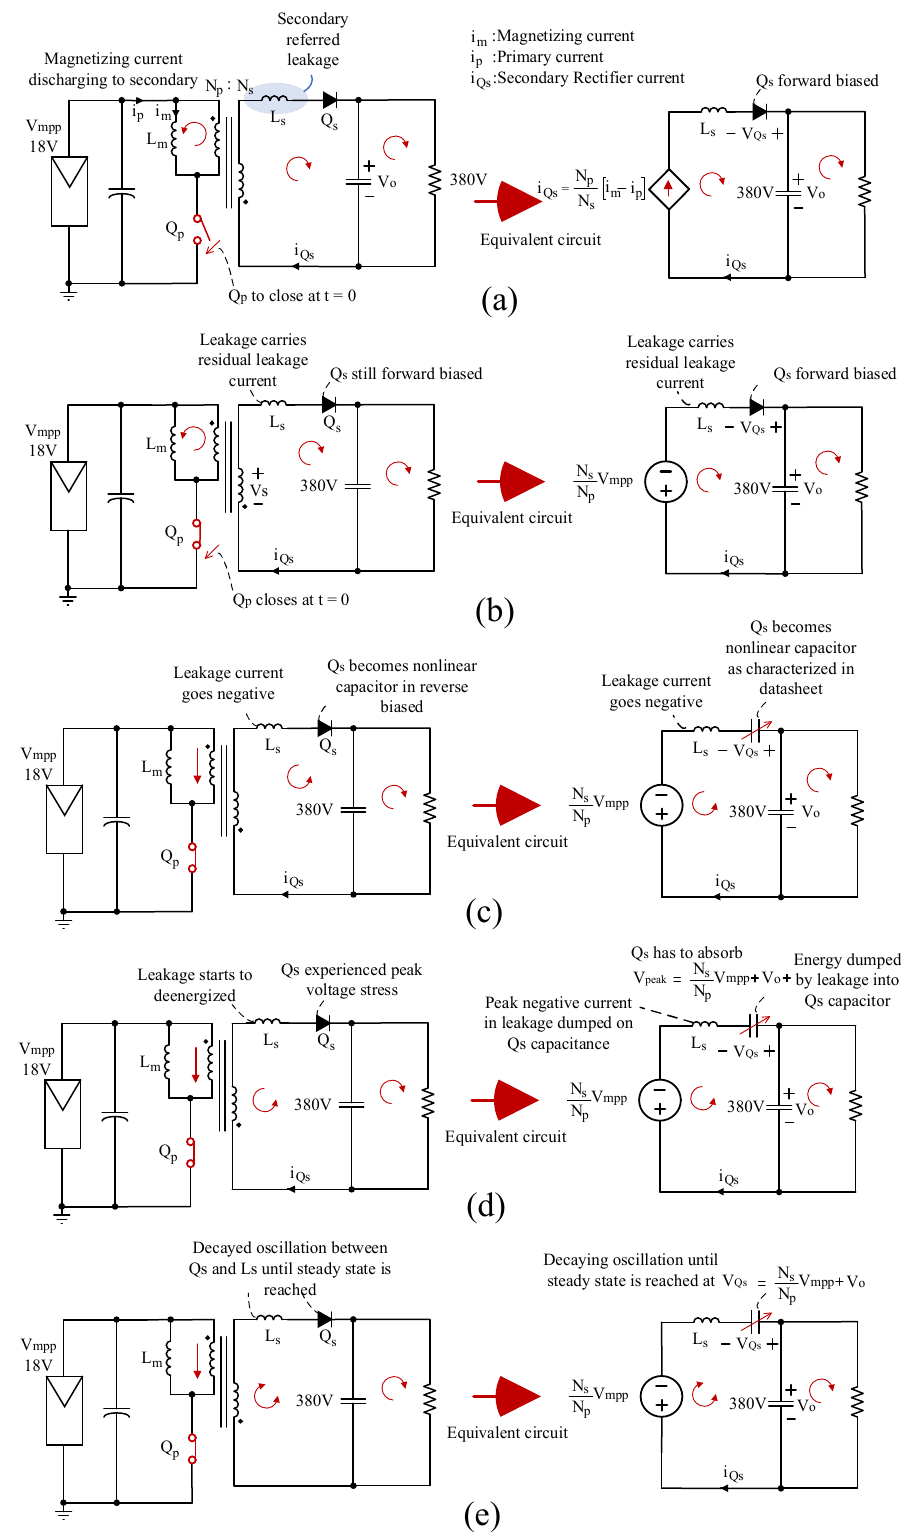
Figure 6. The switching states of snubber-less secondary rectifier. ( a ) State a ( b ) State b ( c ) State c ( d ) State d ( e ) State e.